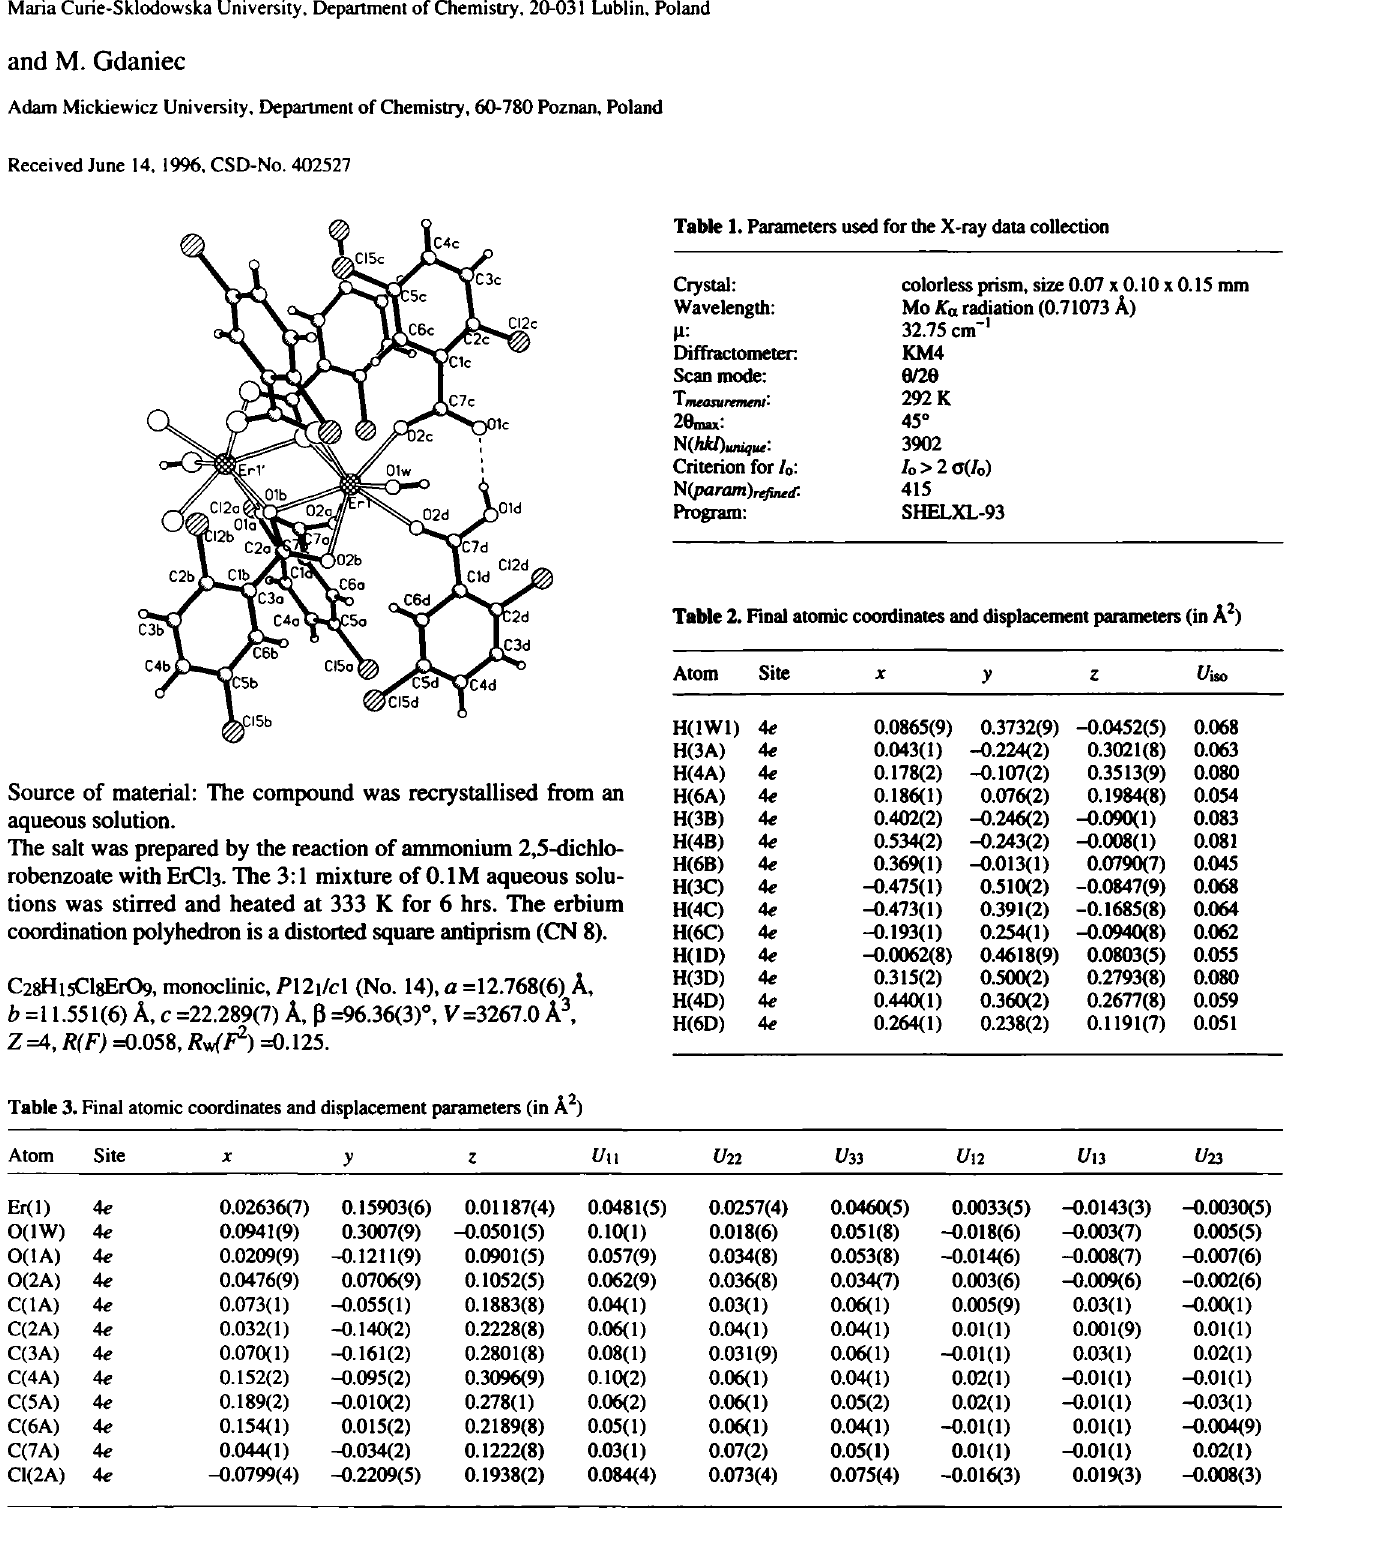
Table 1. Parameters used for the X-ray data collection